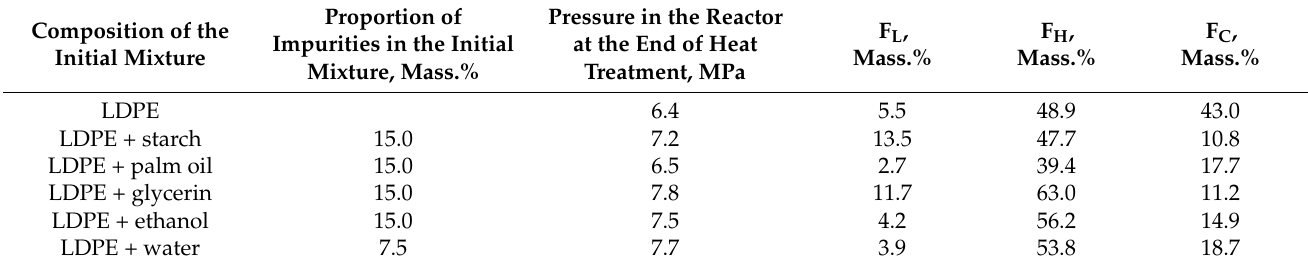
Table 1. Results of the analysis of the pyrolysis liquid obtained from the mixture of LDPE with oxygen-containing